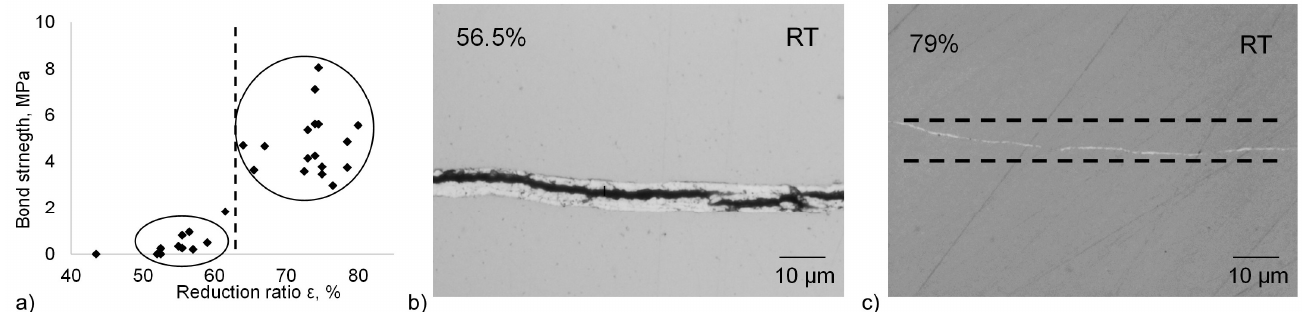
Figure 2. Bond strength of the samples bonded without heat treatment as a function of the reduction ( a ); interfaces of selected samples rolled with reduction ratios of 56.5% ( b ) and 79% ( c ).